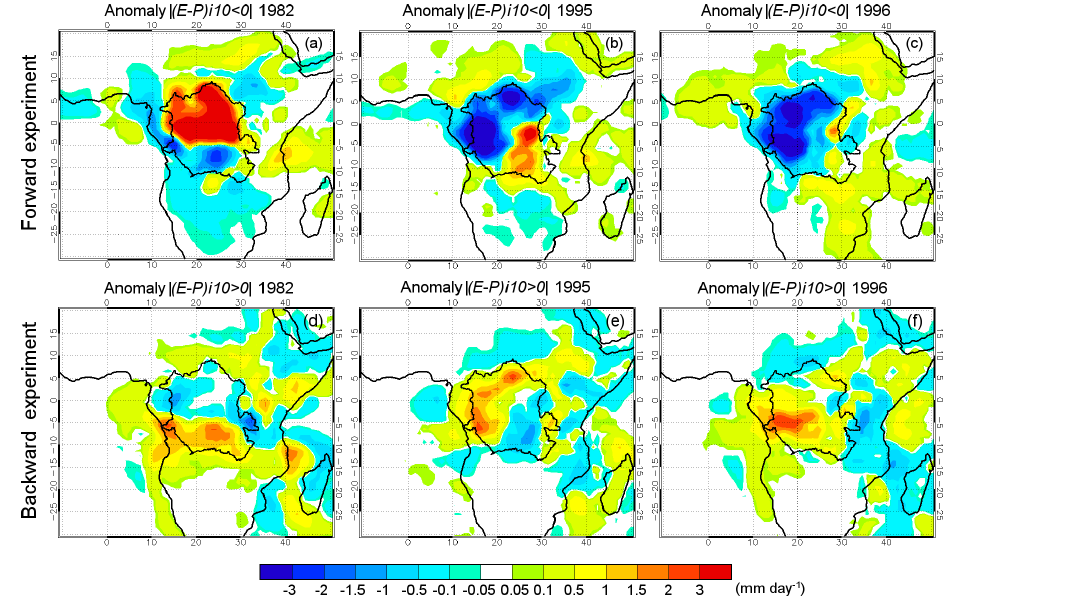
Figure 14. Anomaly of the | ( E − P ) i 10 < 0 | (mmday − 1 ) integrated forward from the Congo River basin in 1982 (severe wet year, a ), 1995 (severe dry year, b ), and 1996 (extreme dry year, c ). Anomaly of the | ( E − P ) i 10 > 0 | (mmday − 1 ) integrated backward from the Congo River basin in 1982 (severe wet year, d ), 1995 (severe dry year, e ), and 1996 (extreme dry year, f ).